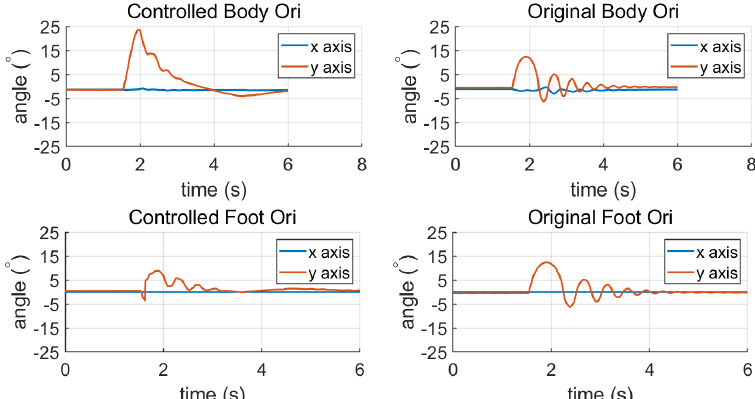
Figure 8. The inclination change of standing balancing. The left is the torso and sole incli- nation with momentum compensation, and the right is the torso and sole inclination without momentum compensation.